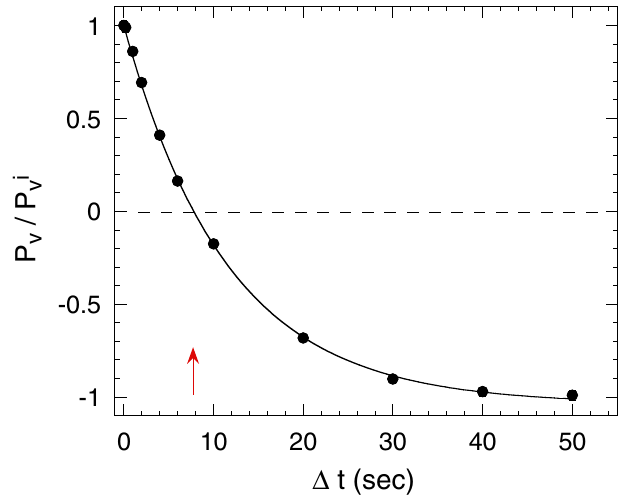
FIG. 2. (Color) Measured average vector deuteron polarization ratios at 1850 MeV =c are plotted vs rf dipole ramp time (cid:1) t [25]. The rf dipole’s frequency range (cid:1) f was 200 Hz; its R Bdl was (cid:1) (cid:2) 16 (cid:6) 1 (cid:4) (cid:5) 10 (cid:3) 6 . 0 : 54 (cid:6) 0 : 03 T mm ; thus, Eq. (5) gives E Bdl (cid:1) (cid:2) 1 : 17 (cid:6) 0 : 01 (cid:4) (cid:5) 10 (cid:3) 6 ; the arrow The fit to Eq. (3) gives E FS shows the (cid:1) t where P (cid:1) 0